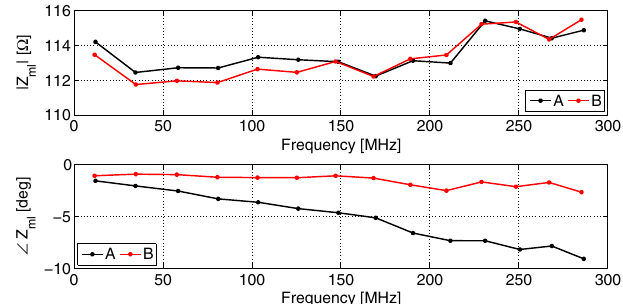
FIG. 19. Modulus and phase of Z ml for the frequencies where (cid:1) ml L ml ¼ (cid:2) ð 2 k þ 1 Þ = 2 . Comparison between the measurements performed with the two different setups: (A) first setup; (B) second